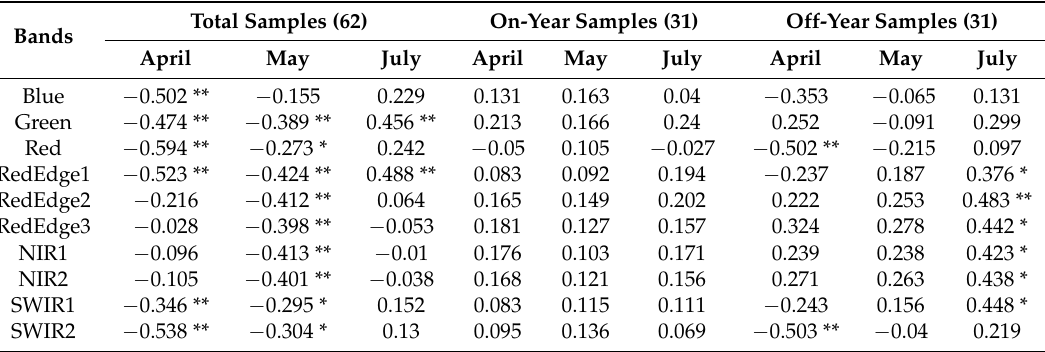
Table 6. Pearson’s correlation analysis